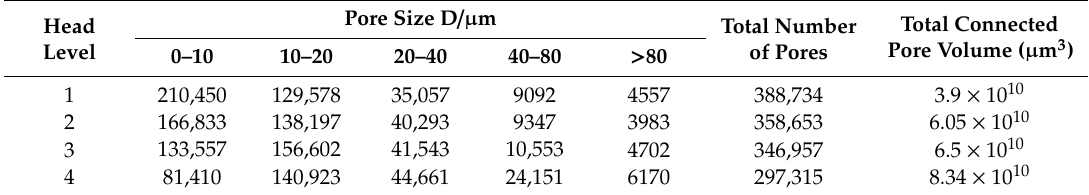
Table 4. Statistics of the number of pores in the seepage process with the 30% fine content.